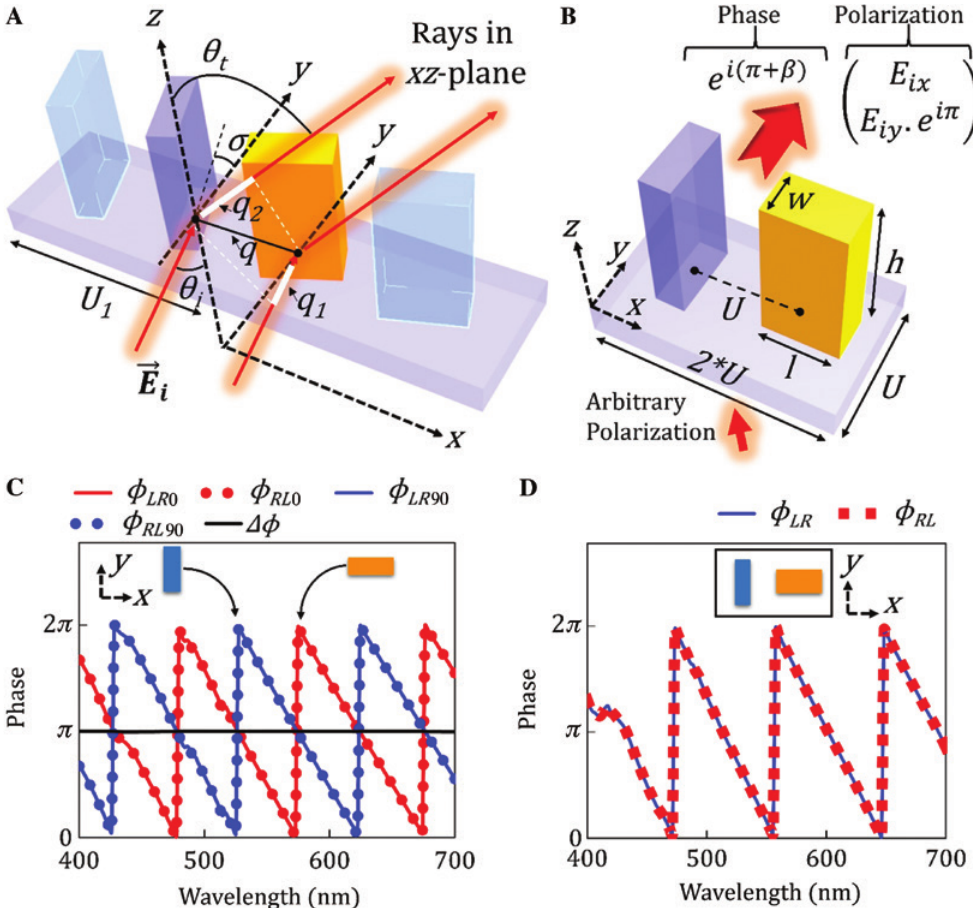
Figure 1: The principle of phase delay for full phase modulation under arbitrary polarisation. (A) The transmitted light from two non-identical parallel or perpendicular nanorods leading to holographic constructive or destructive interference. The phase delay is induced by the displacement q , which is the key factor in obtaining constant phase modulation with polarisation insensitivity. The light rays (incident and transmitted) are drawn in the xz plane. The angle between the long axis of the nanorod and the y -axis is represented as σ . The figure illustrates two cases: (1) non-identical nanorods with angle of 90 ° between each other, (2) non- identical nanorods with angle of 0 ° between each other. (B) Perspective view of perpendicular nanorods satisfying the condition σ = 0 and = 2 q , where 2* U is the global displacement and U is the center to center distance between the adjacent nanorods. Similarly, the parallel U 1 nanorods can also be shown that satisfy aforementioned condition (see Figure S2). Therefore, by varying the dimensions of the nanorods with parallel and perpendicular orientations simultaneously, the metasurface modulates polarisation-insensitive wavefront manipulation. (C) The simulated phase of cross-polarised transmitted lights, for example, φ and φ represent the phase of transmitted RCP light under LR 0 LR 90 LCP illumination with the nanorods having rotation angles of 0 ° and 90 ° (between the long-axis and x-axis), respectively. The orthogonal nanorods demonstrate a broadband phase difference ( Δ φ ) equal to π . The length, width, and height of the nanorod are 220 nm, 70 nm and 600 nm, respectively. (D) The metasurface element containing two different orthogonal nanorods with displacement ( U = 260 nm) possesses identical cross-polarised phase shifts ( φ and φ ). The yellow and green nanorods have parameters ( l , w , h ) = (220, 70, 600) and LR RL ( l , w , h ) = (235, 110, 600) in nanometer units, respectively. This metasurface element introduces no phase difference ( Δ φ = 0) under both CP incidences with the same slope and